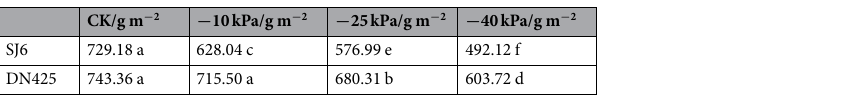
Table 3. Yield of SJ6 and DN425 under drought treatment. Alphabets indicates differences between drought treatments values (P ≤